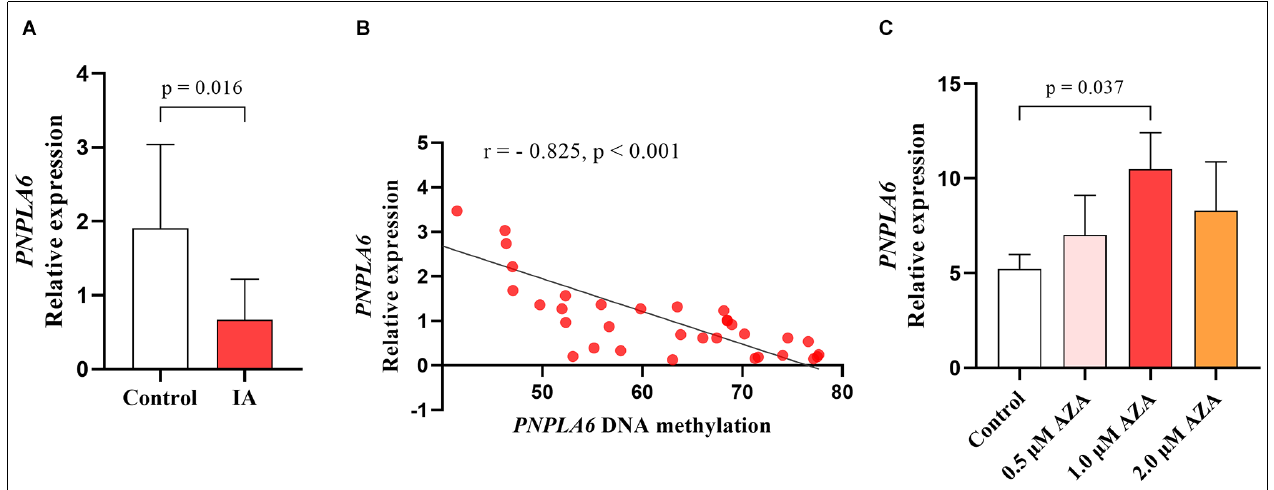
FIGURE 5 | The significant association between PNPLA6 mRNA expression and DNA methylation. (A) PNPLA6 mRNA expression was much lower in IAs than in healthy controls. (B) The PNPLA6 expression was significantly associated with DNA methylation in all individuals. (C) The changes of PNPLA6 expression in the cell lines treated with AZA.